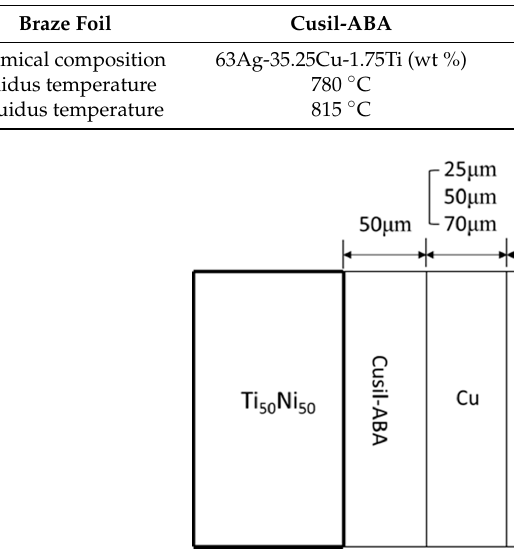
Table 1. Compositions and melting behaviors of three filler foils.